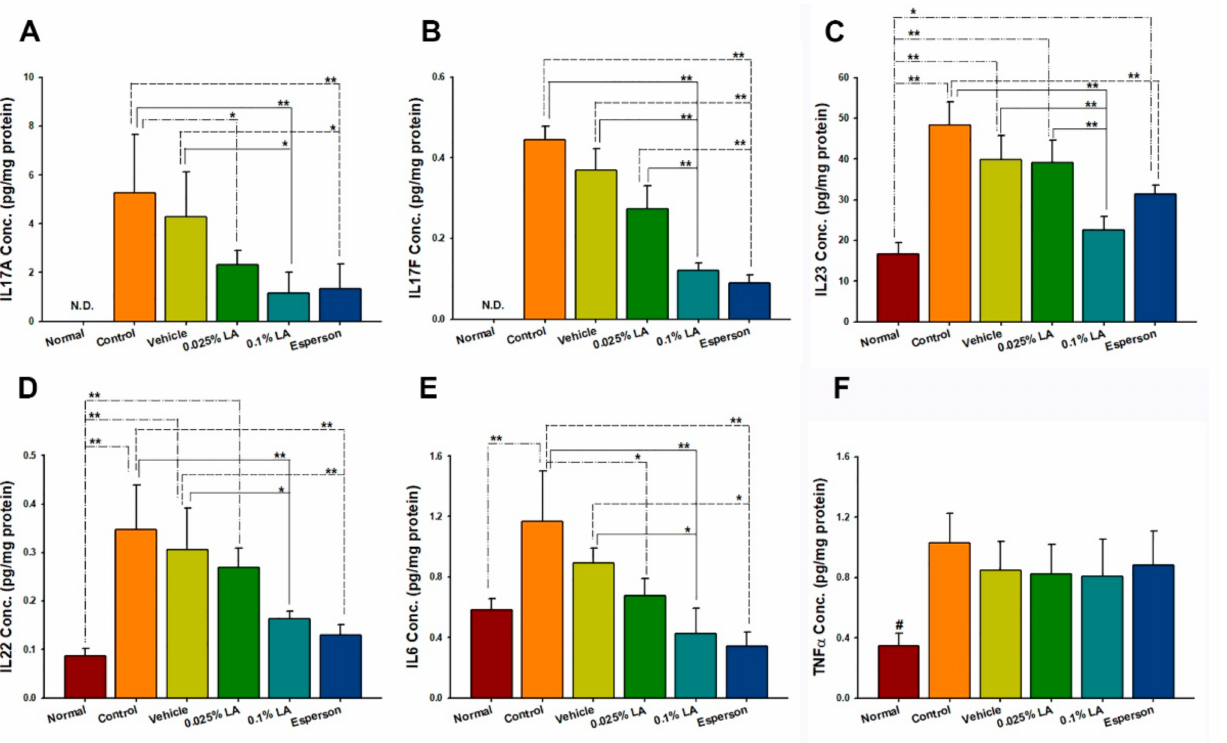
Figure 3. 0.1% LA and DXM Inhibited ( A ) IL-17A, ( B ) IL-17F, ( C ) IL-23, ( D ) IL-23, and ( E ) IL-6 but not ( F ) TNF- α Protein Expression in Psoriasis-like Skin. IL, interleukin; # p < 0.01, compared to all the other groups; * p < 0.05; ** p <